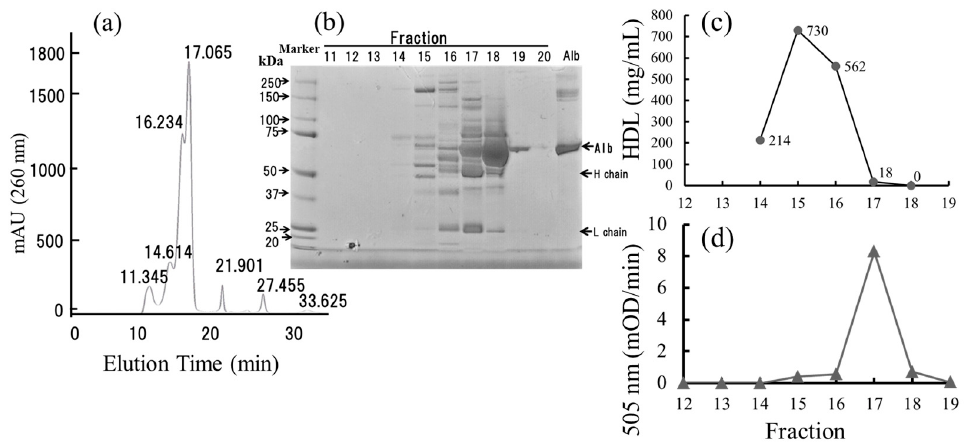
Figure 5. The HPLC analysis of the carrier of hydroperoxides. ( a ) 50 microliters of plasma from a healthy subject was separated on an OH pak SB-804HQ column at a flow rate of 0.5 mL/min and fractionated at 1 min intervals. The numbers on each of the peaks indicate the elution time (min); ( b ) The eluted fractions were collected in 0.5 mL fractions and analyzed by 4%–12% sodium dodecyl sulfate poly-acrylamide gel electrophoresis (SDS PAGE) as described in the Section 4. Each fraction was 0.5 mL in volume. Fraction 11 was collected from elution time 10 to 11 min, fraction 12 from 11 to 12 min, and additional fractions in the same way. Albumin is a major serum protein and was eluted mainly in fraction 18 (elution time is 17–18 min). Alb, Albumin; H chain, Immunoglobulin heavy chain; L chain, Immunoglobulin light chain; ( c ) Each eluted fraction (fractions 14–18) was used for the measurement of the HDL concentration ( ● ), as described in the Section 4. The HDL concentrations were expressed in numbers (214, 730, 562, 18, and 0) on each figure; ( d ) Each eluted fraction (fractions 12–19) was used for the measurement of the Fe-ROMs values.